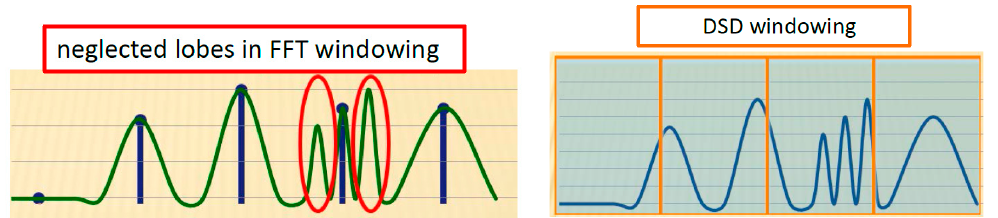
Figure 13. Effects of windowing based on FFT ( left ) and DSD ( right ).